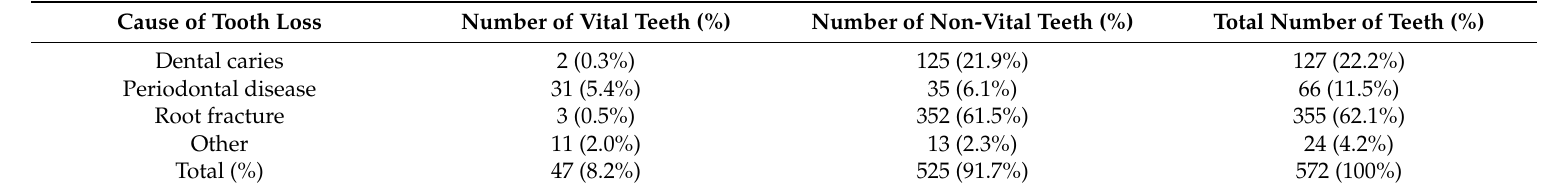
Table 3. Tooth loss according to cause and vital versus non-vital tooth